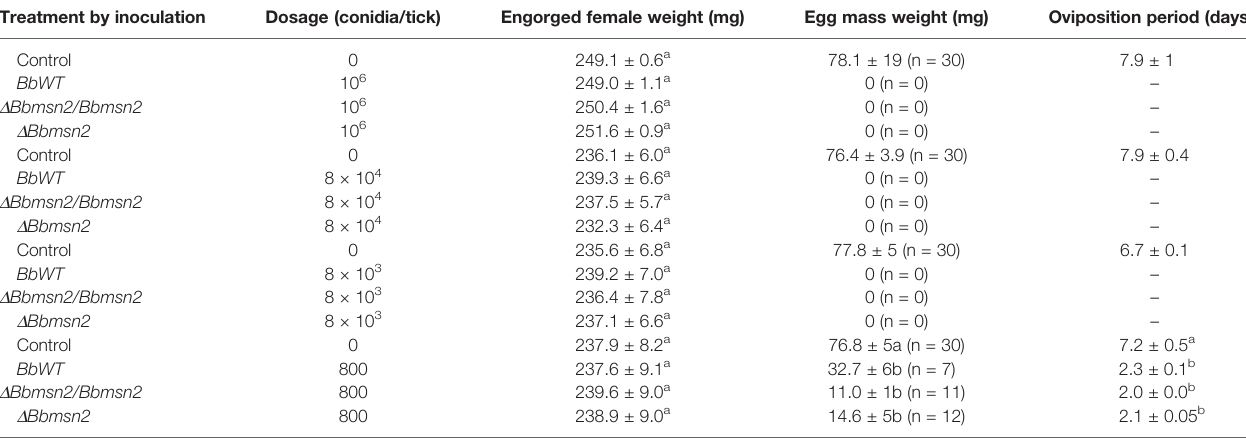
TABLE 2 | Biological parameters of Rhipicephalus microplus engorged females treated by an intra-hemocoel injection with 5 µl of Tween 80 ® 0.01% (control), or 5 µl of conidial suspension of Beauveria bassiana strains ( BbWT , D Bbmsn2/Bbmsn2 and D Bbmsn2 ) at 1.6 × 10 5 conidia ml − 1 (800 conidia/tick), 1.6 × 10 6 conidia ml − 1